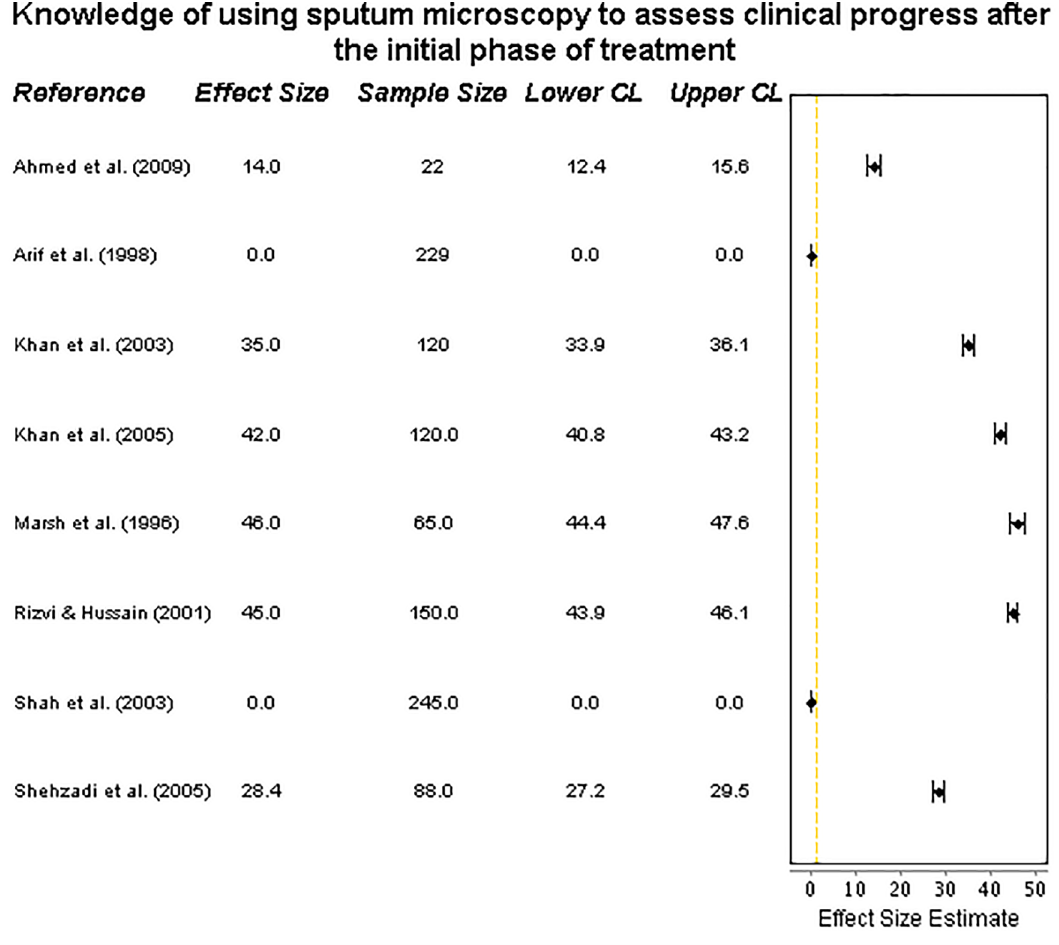
Fig 6. Forest plot on assessing clinical progress. Forest plot visualising data on practitioners’ knowledge of using sputum microscopy to monitor treatment progress (ISTC Standard 10). CL = 95% Confidence Level.